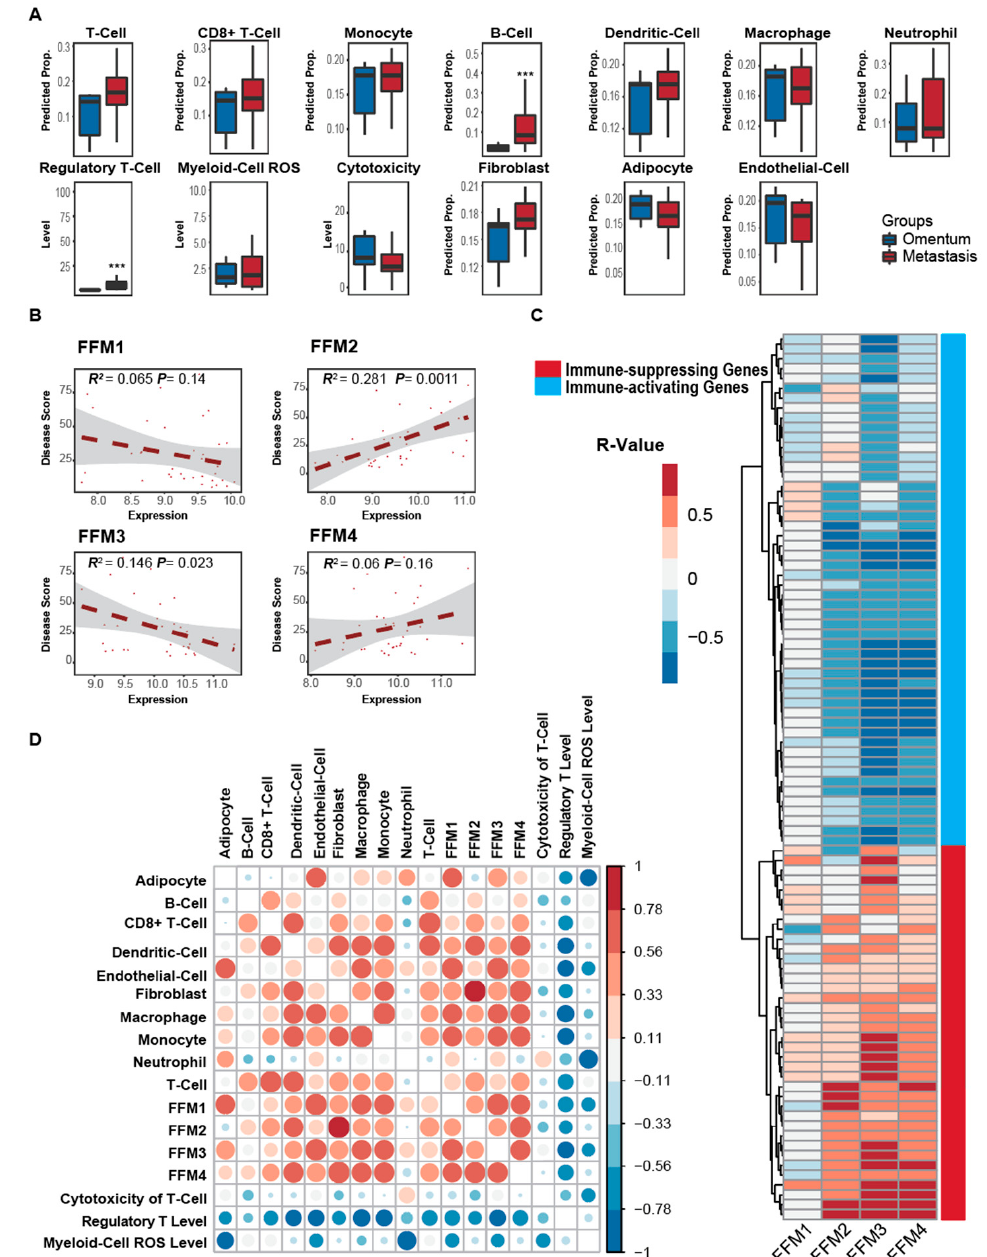
Figure 4. Analysis of stromal cellular composition of omental metastasis in human ovarian cancer patients with varying extent of disease spread in the omentum (GSE71340). ( A ) Comparison of the proportion of stromal cell types present in omentum with minimal metastases (omentum) and omentum with significant metastases (metastasis). ( B ) Scatter plots depicting the correlation between the expression of the 4 fibroblast functional modules (FFM1–4) with the extent of disease in the omentum specimen (disease score). ( C ) Heatmap showing the Spearman correlation of 4 fibroblast functional modules and immune-associated markers in tissues. Red or blue boxes indicate positive or negative correlation between the immune-associated marker and the corresponding fibroblast functional module (FFM1–4), respectively. Grey boxes indicate no correlation. Red and blue bars on the right depict the immune-suppressing and immune-activating markers, respectively. ( D ) A correlation analysis between the stromal cell types in the metastasis. The color scale for R -values are provided on the right. The sizes of the dots are also proportional to the magnitude of the R -value. *** p <